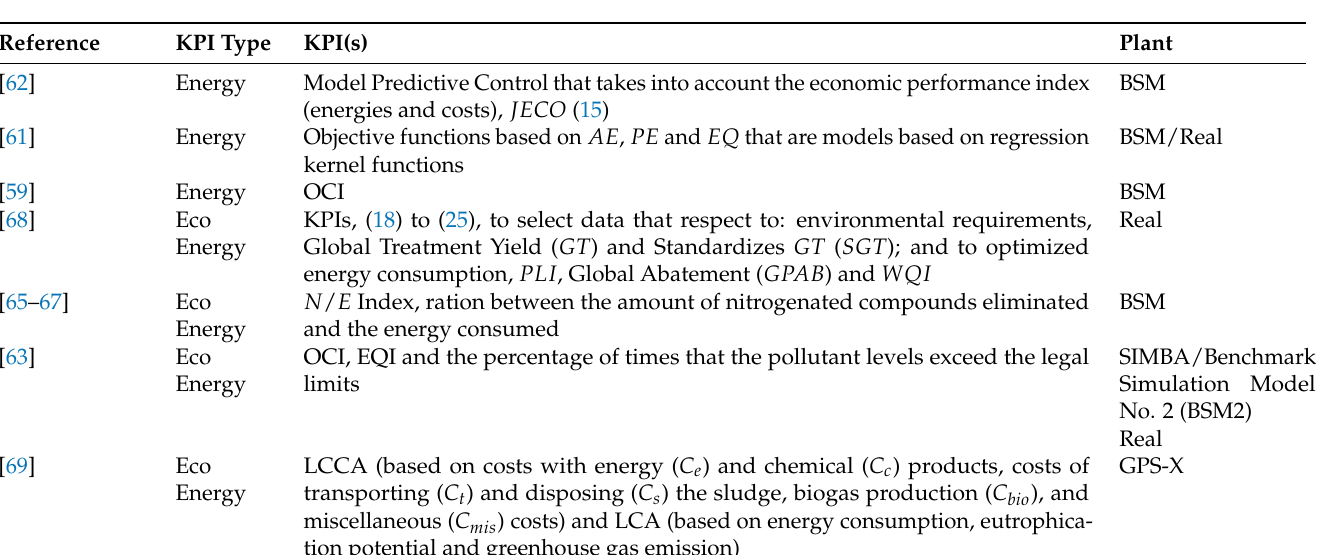
Table 2. Resume of the selected papers related to WWTP KPI-based control and